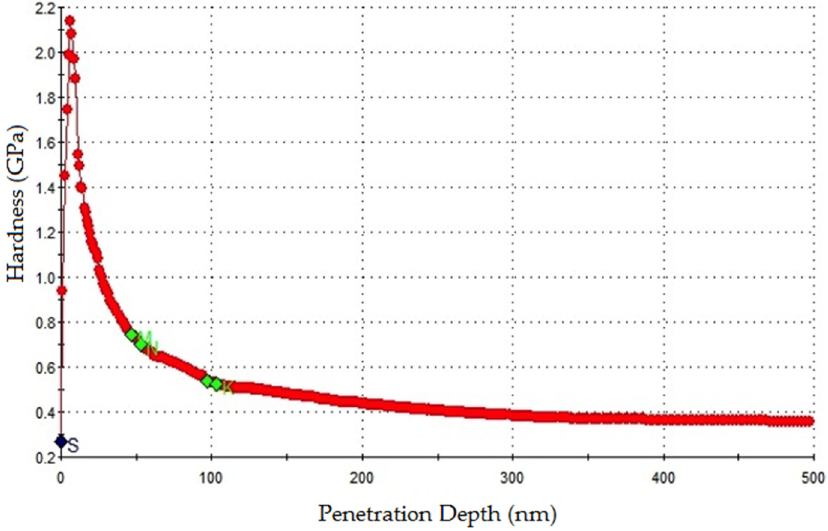
Figure 12. Variation of hardness with the depth of indentation on vinyl ester matrix.